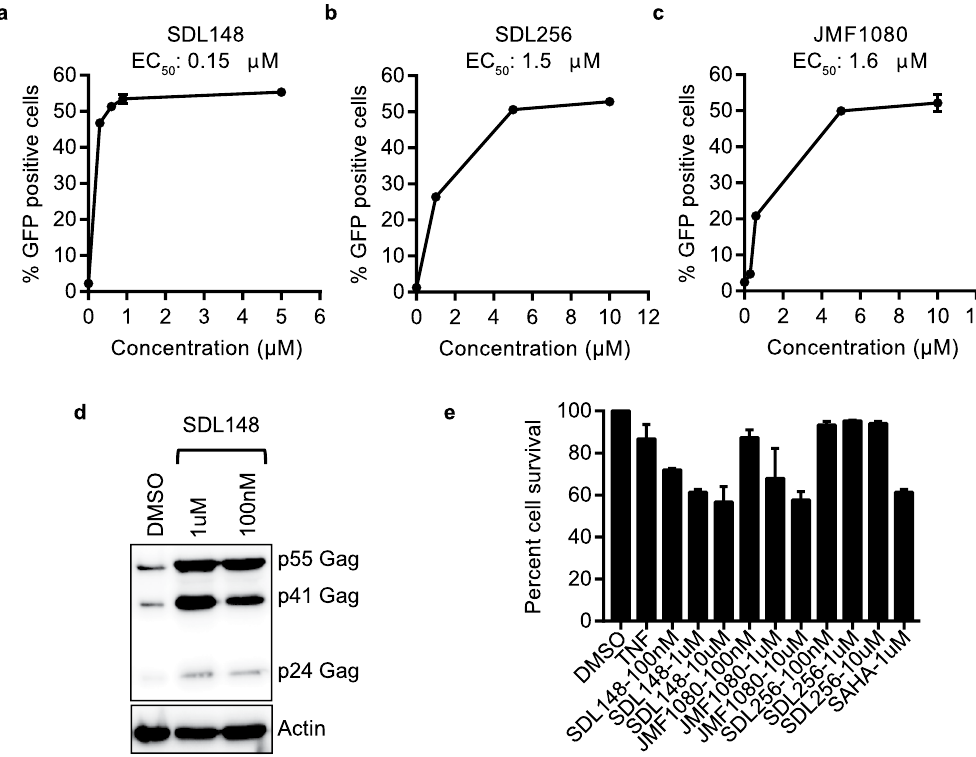
Figure 3. Low-toxicity isoform-targeted compounds induce HIV-1 gag. ( a–c ) EC 50 measurements for largazoles. JLAT10.6 cells were incubated with indicated compounds for 24 h at increasing concentrations and FACS performed to quantify the percent of GFP positive cells. ( d ) Largazole induces HIV Gag proteins. JLAT10.6 cells were incubated with SDL148 for 24 h and Western blot performed for HIV Gag proteins. ( e ) Toxicity profile of largazoles. JLAT10.6 cells were incubated with compounds at indicated concentrations and MTT toxicity assay performed as described in Methods. Data indicates mean values, and error bars indicate mean ± s.e.m. (n ≥